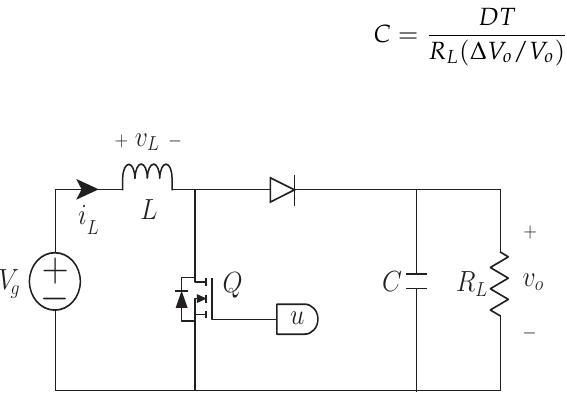
Figure 1. Schematic of: Boost